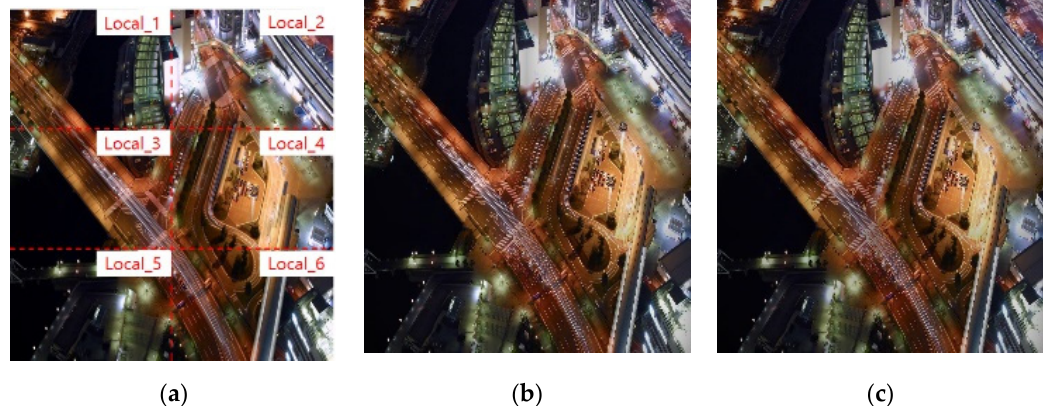
Figure 11. Local dimming simulation result. ( a ) Original image; ( b ) Conventional local dimming; ( c ) Proposed local dim- ming.